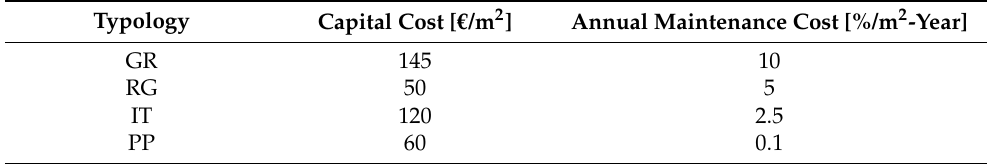
Table 4. Capital and annual maintenance costs for